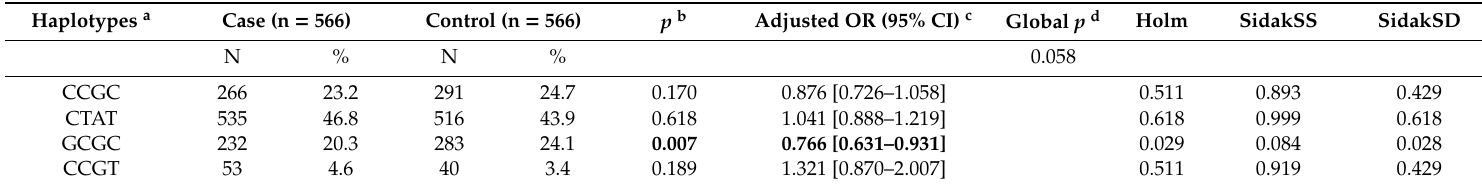
Table 7. Frequencies of inferred haplotypes in cases and controls and their associations with NIHL